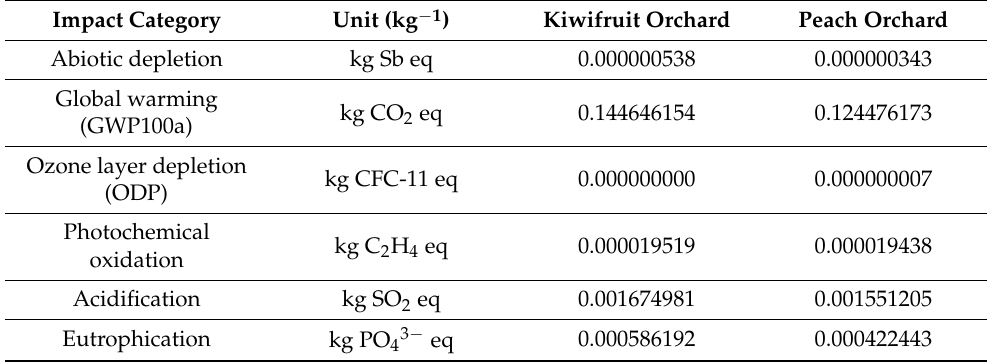
Table 3. Life cycle impacts per kg per year of harvested product from the different fruit orchard systems (kiwifruit orchard and peach